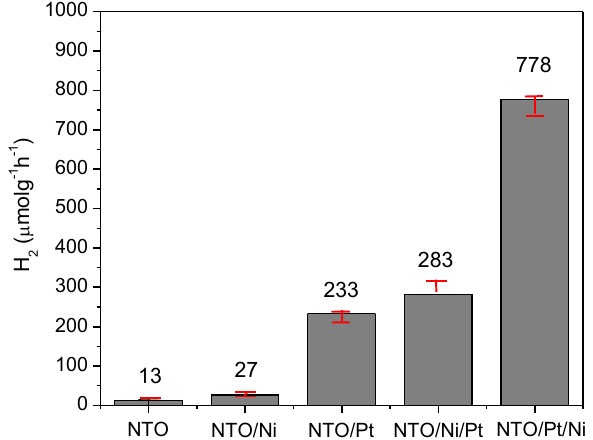
Figure 10. H 2 evolution rates from photocatalytic photo-reforming reaction under metallic and bi-metallic NTO samples.